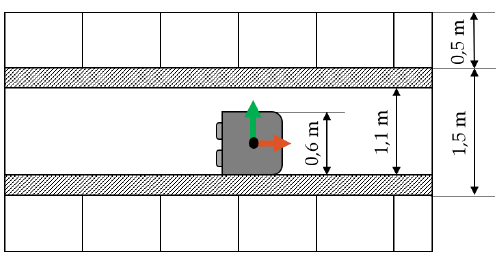
Figure 12. Dimensions of an AGV in an aisle for the quantification of performance requirements.